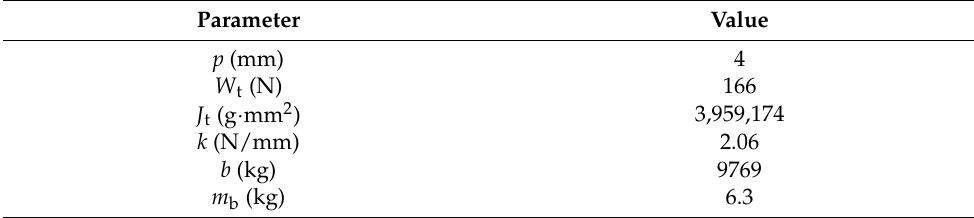
Figure 5. The novel experimental system of the DBoBSI in ISD system. Table 1. The parameters in the experiment system of the DBoBSI in ISD